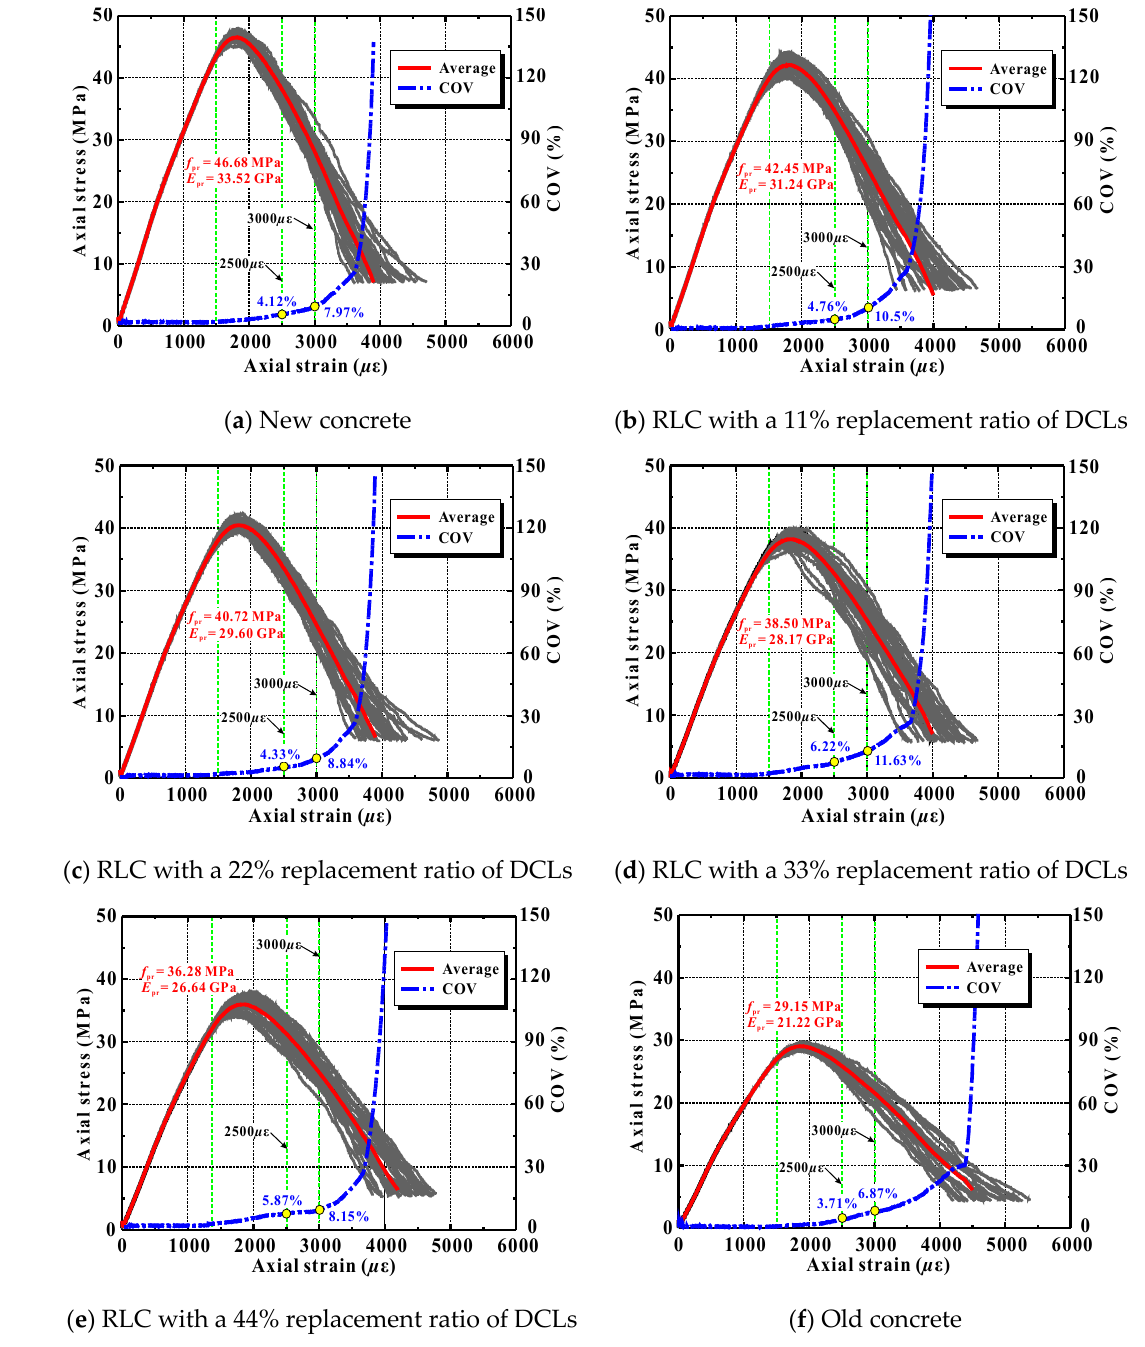
Figure 12. Simulated stress–strain curves of ordinary concrete and recycled lump concrete (RLC).